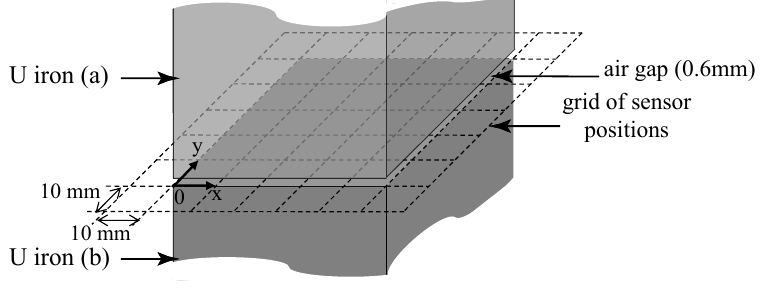
Figure 7. Sensor positions in the airgap plane.